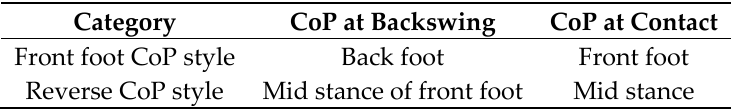
Table 1. Categorization rules for classifying someone as a front foot vs. reverse style COP (Ball and Best,